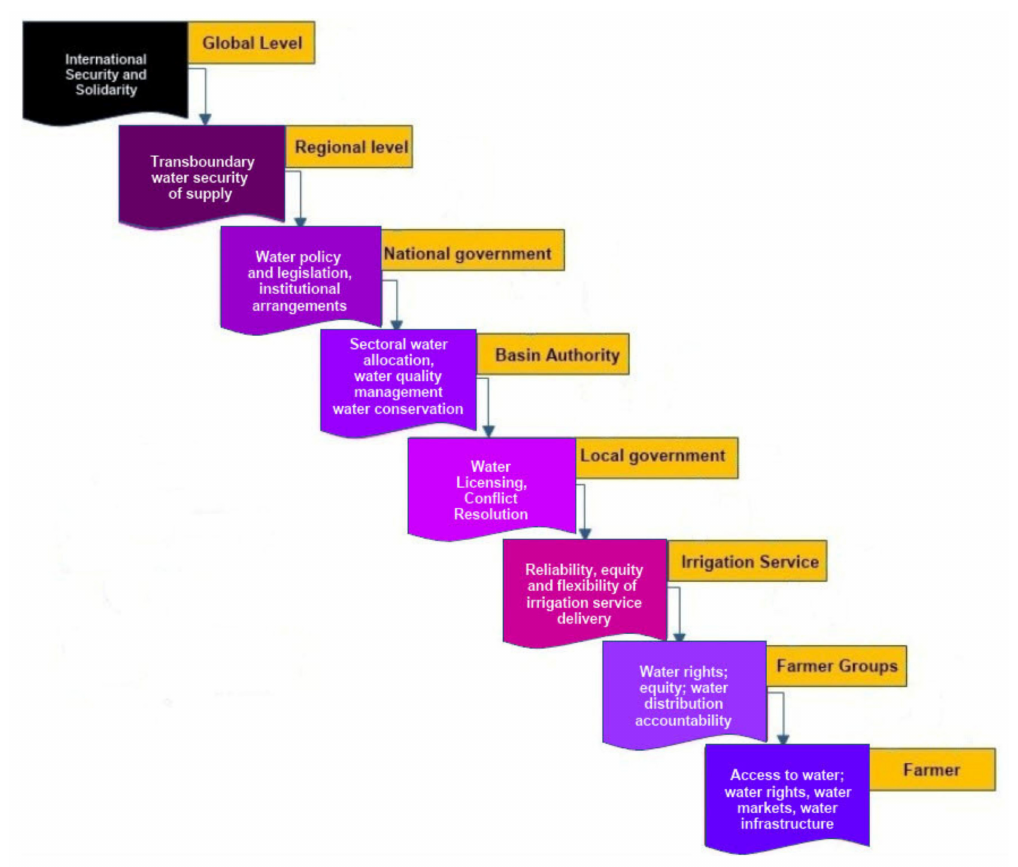
Figure 6. Global water management chain image constructed from